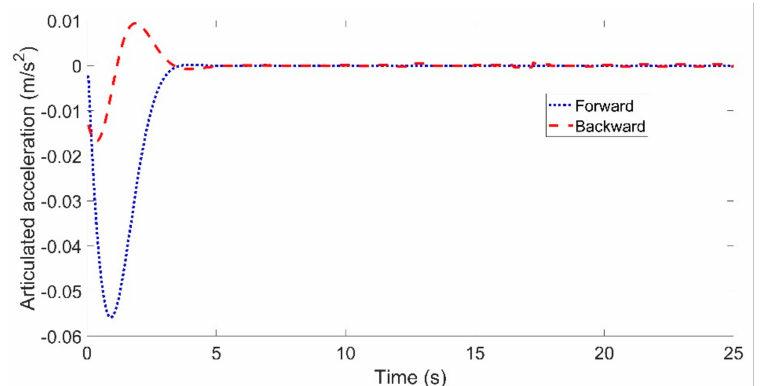
Figure 9. Articulated acceleration for the comparison between the forward and backward Euler method for the circular trajectory.